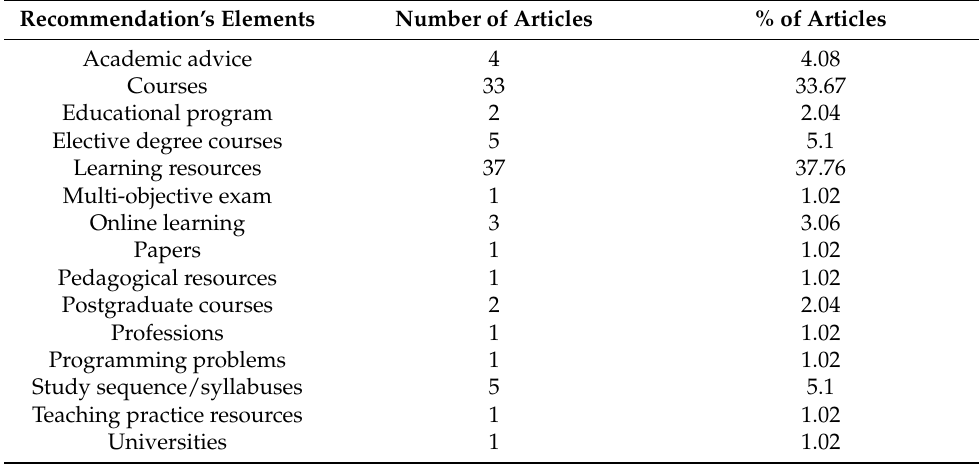
Table 7. Percentage number of articles according to recommendations